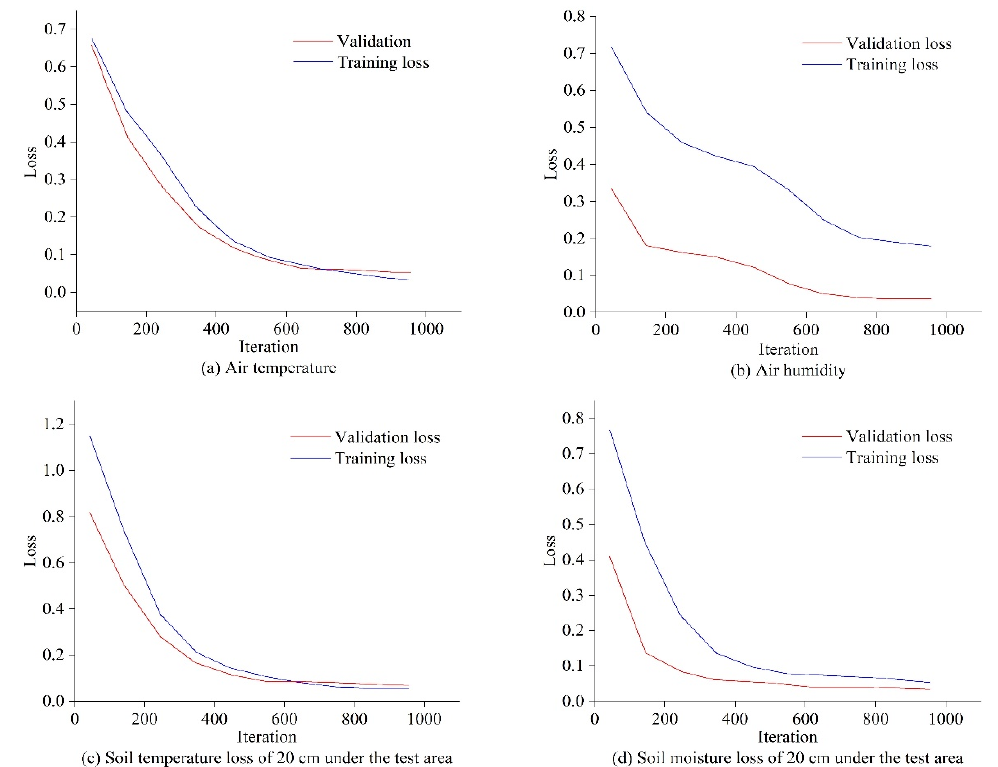
Figure 10. Variations in the loss function results for various sensors.